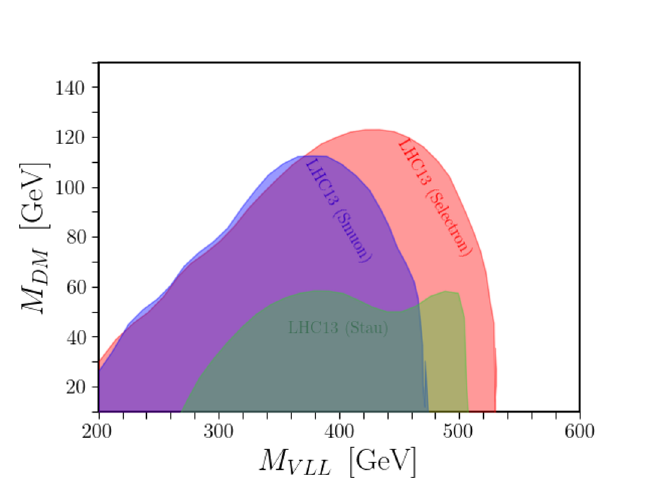
Figure 2 . Current LHC limits on vector like leptons in our model. The shaded regions are excluded by LHC searches of pp → l + l − + /E with l = e, µ, τ . T